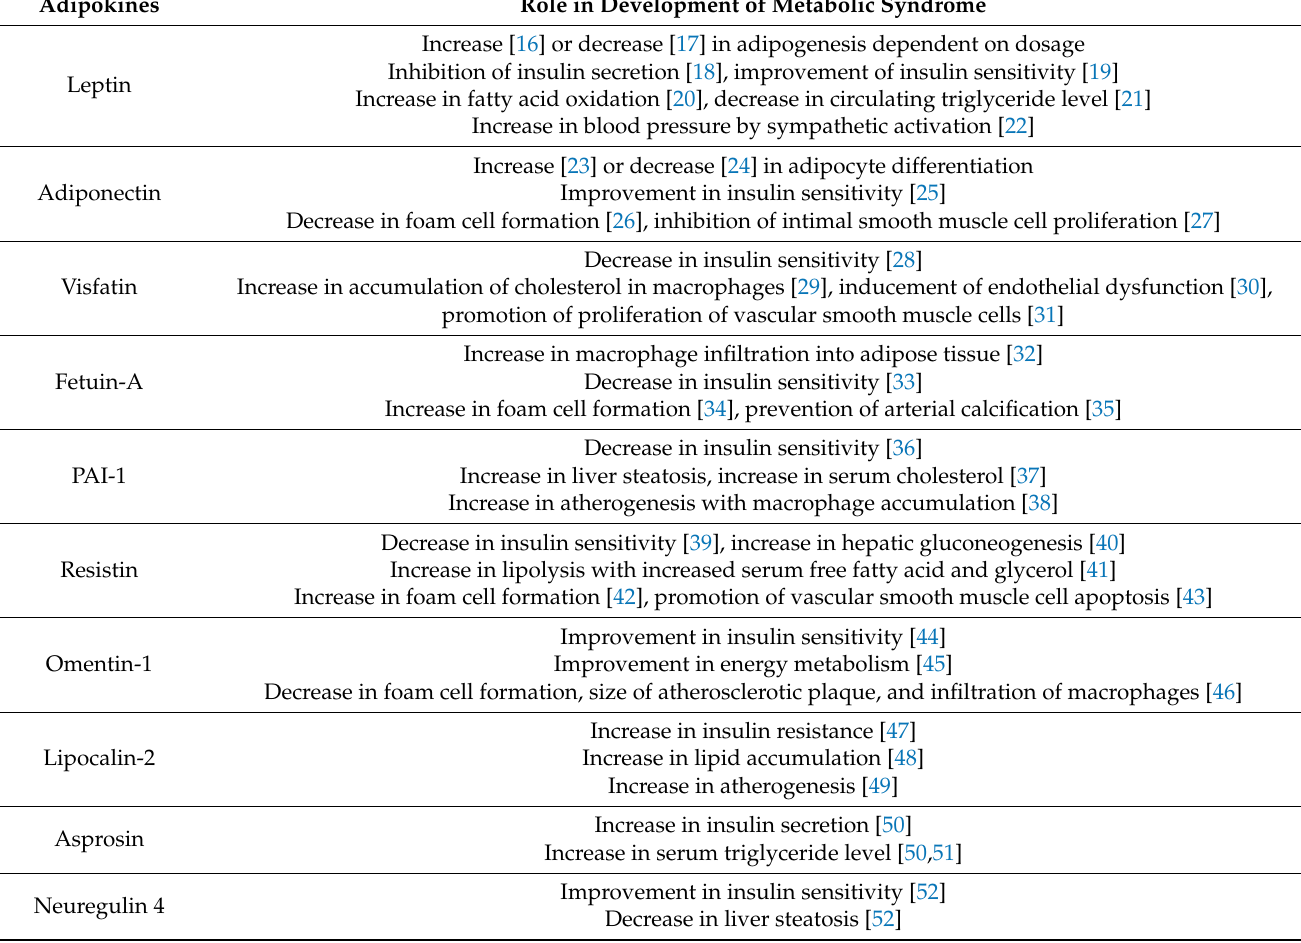
Abbreviations: PAI-1, Plasminogen activator